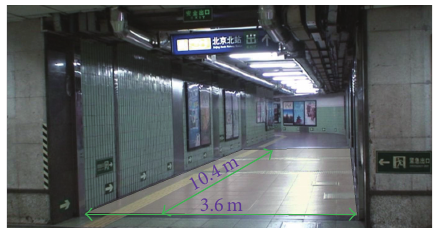
Figure 1: The snapshot of the selected walkway.